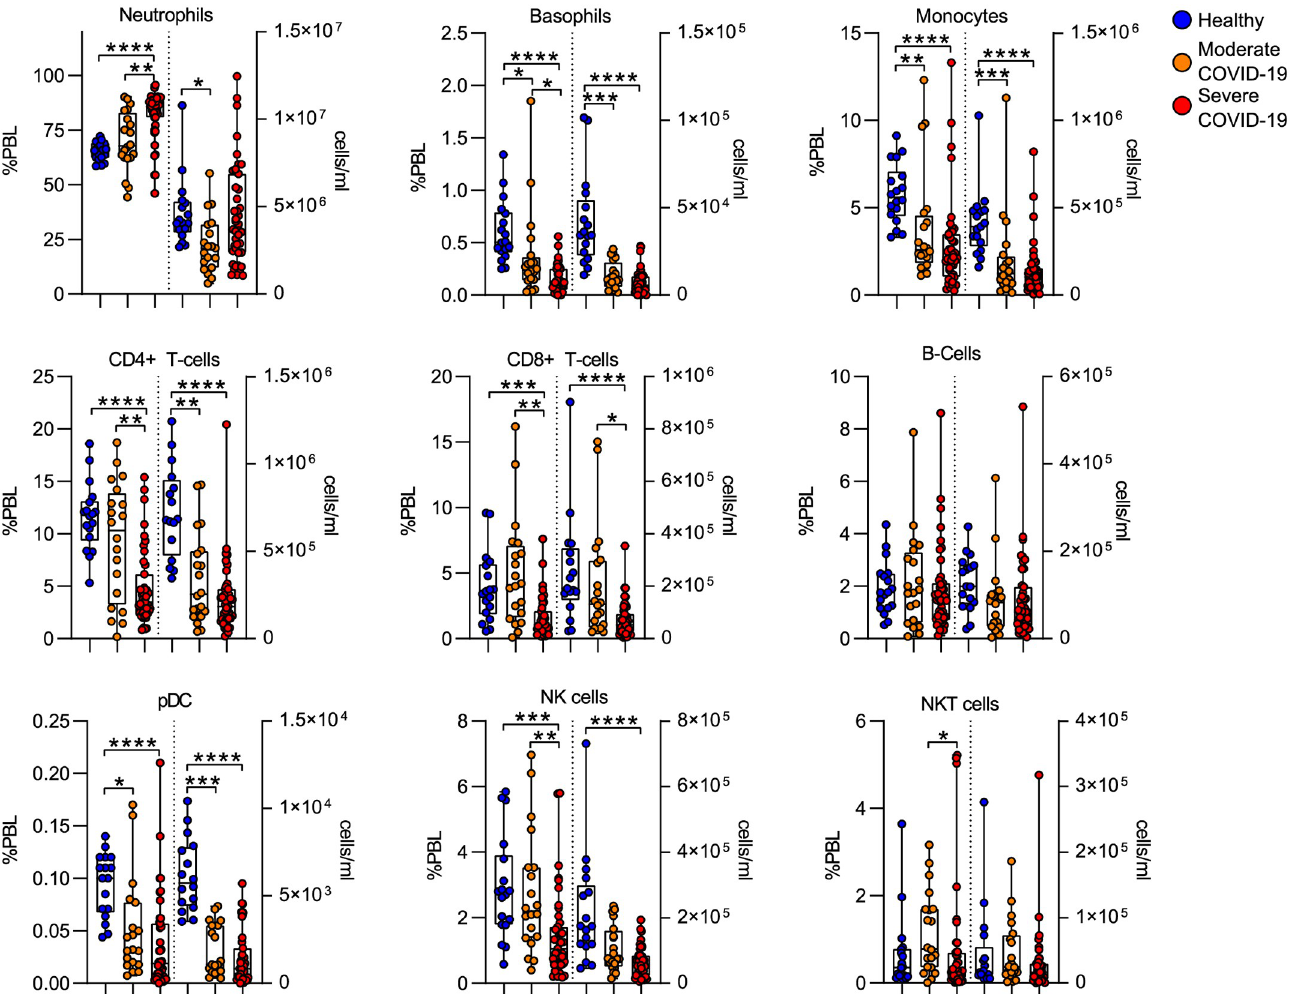
Fig 2. Effect of COVID-19 on circulating leukocyte populations. Leukocyte populations were manually gated based on canonical surface marker expression. The frequency of CD45+ peripheral blood leukocytes (%PBL) and the absolute concentration of cells (cells/ml) were calculated. Box plots represent 25-75 th percentile with line defining group median, with all data-points overlying. Error bars extend from minimum to maximum values. � p < 0.05, �� p < 0.01, ��� p < 0.001, ���� p < 0.0001 by Dunn’s multiple comparisons test after nonparametric (Kruskal-Wallis) ANOVA with correction FDR < 1% (Benjamini, Krieger and